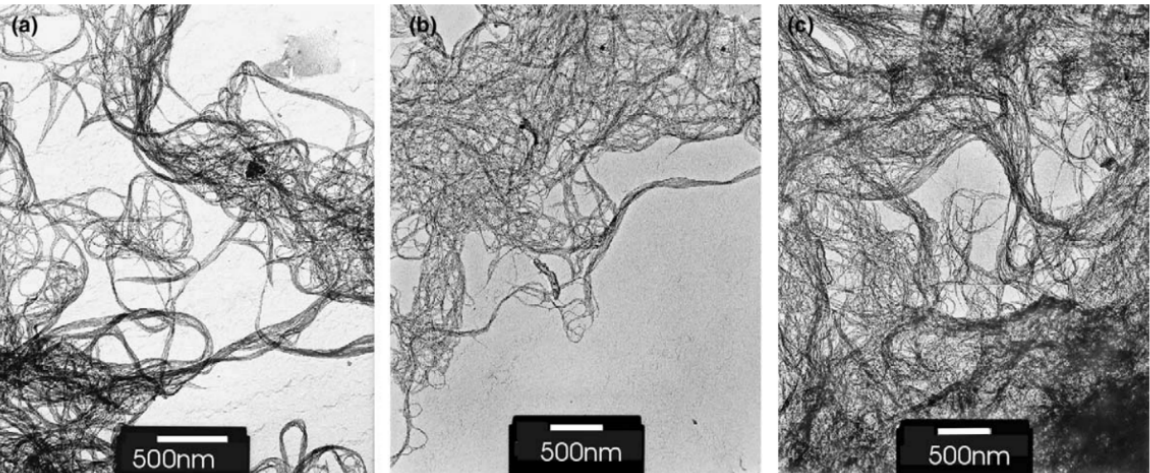
Figure 2. TEM images of samples at 100 kV: ( a ) control unexposed samples; ( b ) exposed to SF 6 at − 200 V bias; ( c ) exposed to CF 4 at -200 V bias. Reprinted with permission from Ref. [45]. Copyright 2004 Elsevier.